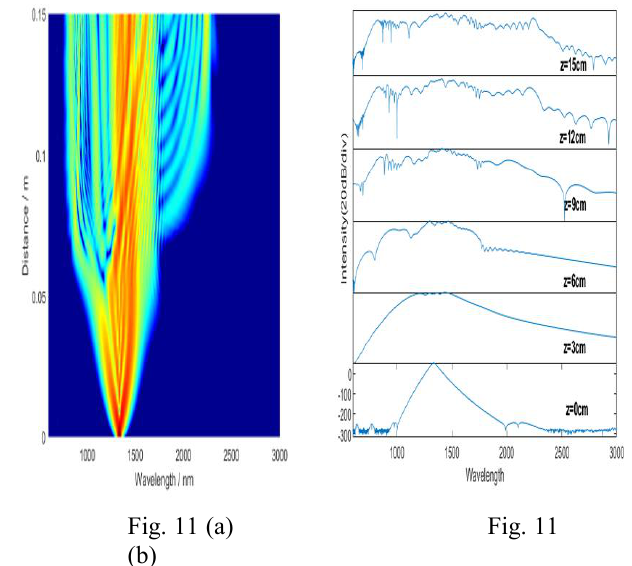
Figure 10: Density plot of spectral profile Fig. 10 (a) and Spectral profile Fig. 10(b) of supercontinuum generation of a 15cm long silica PCF at peak power of 2kW with pulses of 50fs duration.